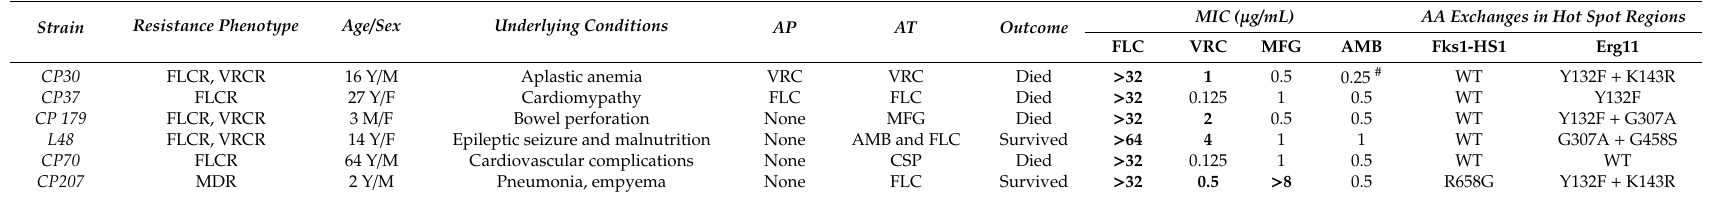
Table 1. Clinical data and microbiological properties of six clinical strains included in this